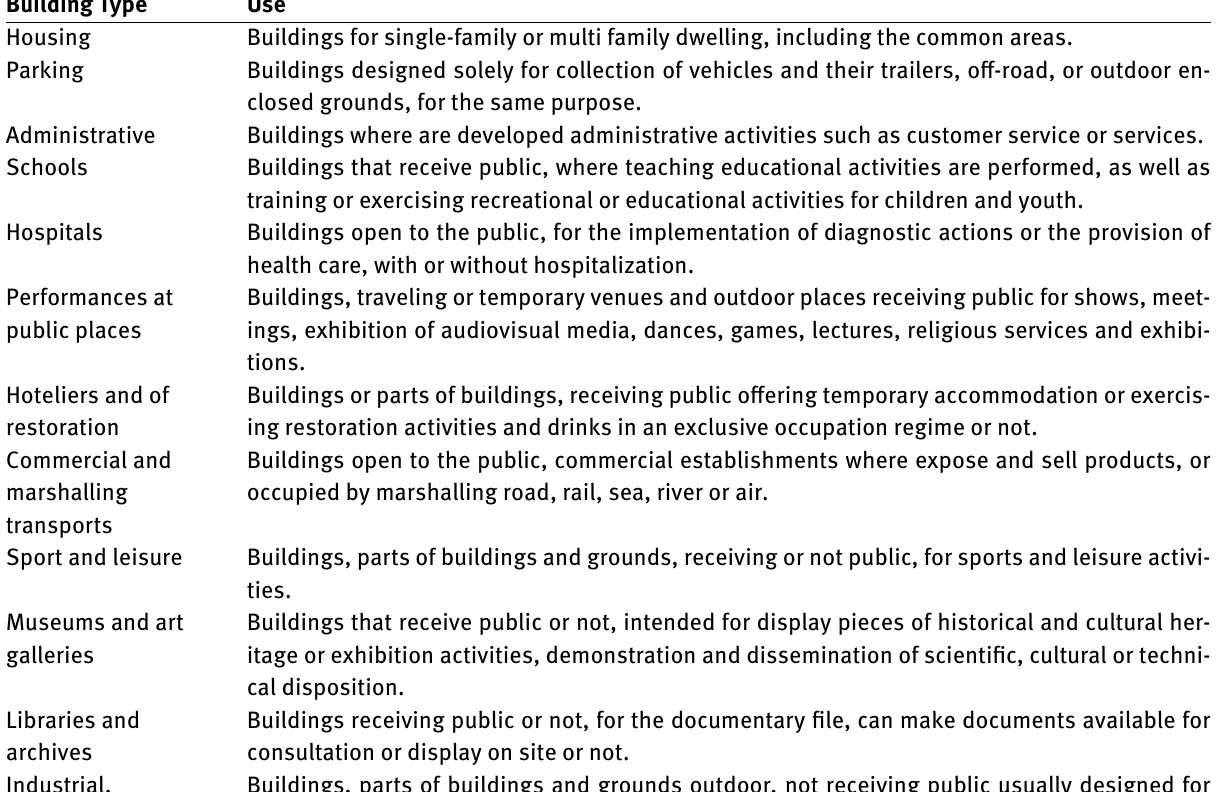
Table 1: Main types of buildings according to their use.